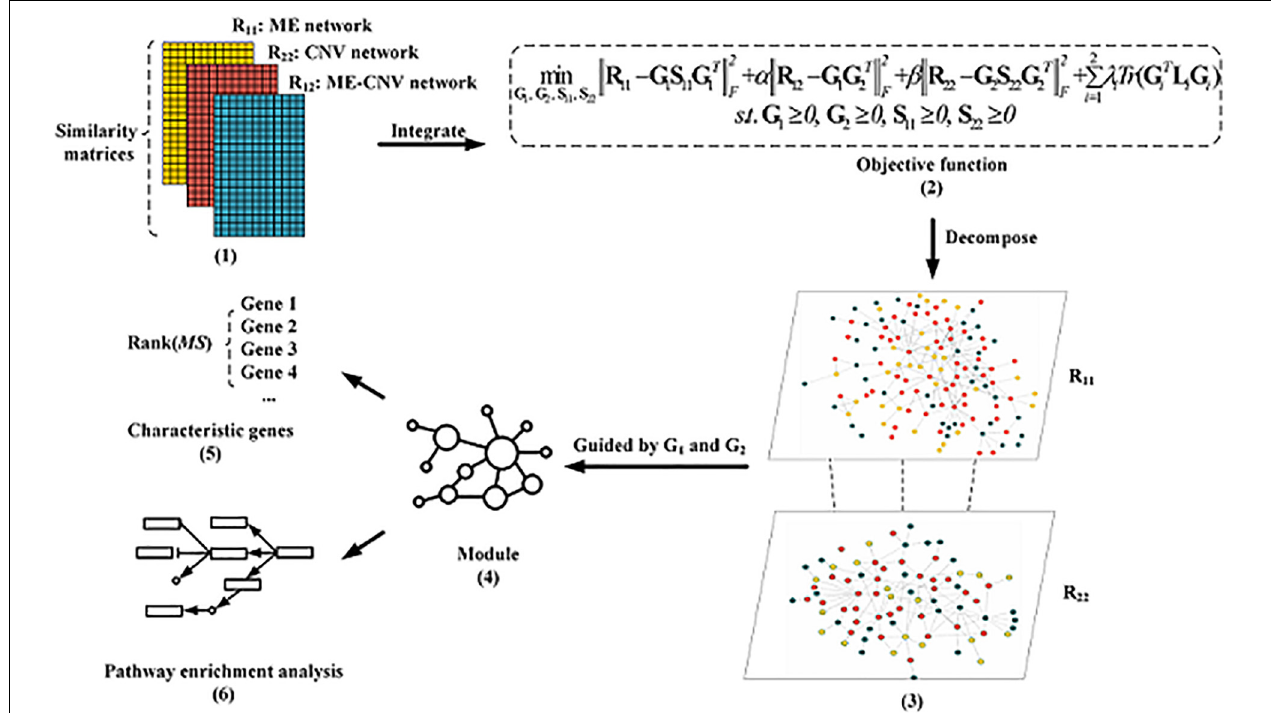
FIGURE 1 | The overall workflow of the non-negative matrix factorization network analysis (NMFNA) for identifying modules and characteristic genes by integrating methylation (ME) and copy number variation (CNV) data of pancreatic cancer (PC).